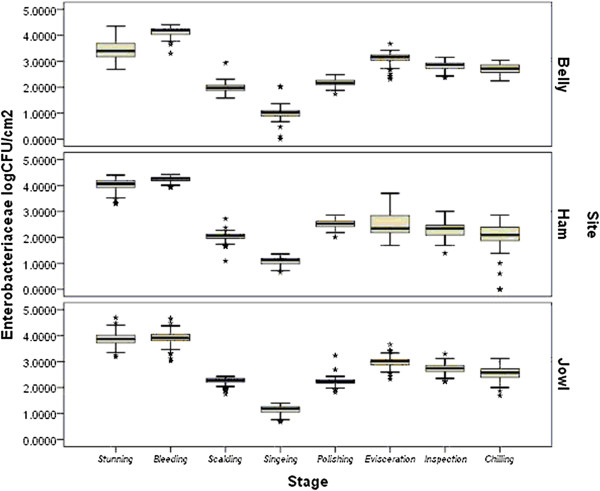
Mean Enterobacteriaceae counts (log cfu/cm2) on jowl, belly and ham at different stages of the slaughter process. Broken line indicates Enterobacteriaceae limit according to the performance criteria of Regulation (EC) No 2073/2005.